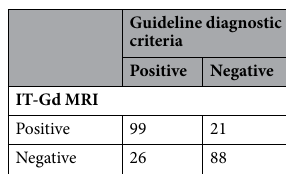
Table 2. Cases of positive and negative results of clinic diagnose and IT-Gd MRI among all ears (234 ears).